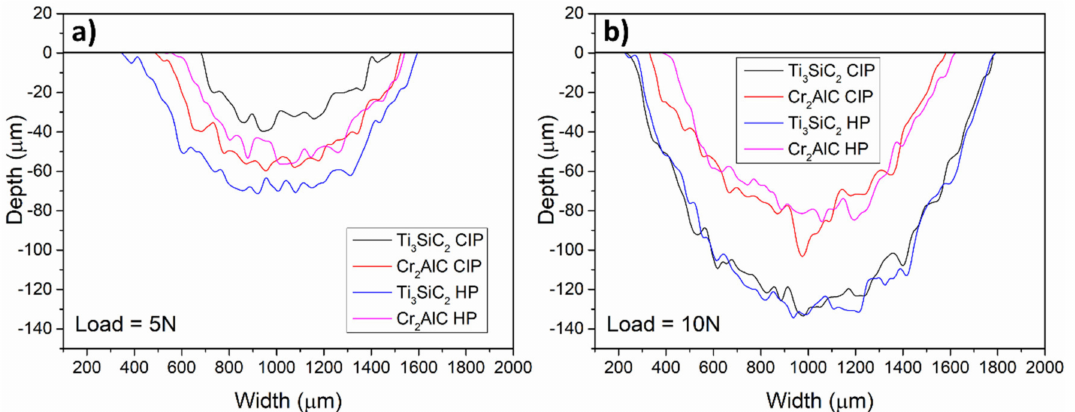
Figure 13. The 2D profiles at the center of the wear track of cold isostatic pressed and sintered (CIP) and hot-pressed (HP) Ti 3 SiC 2 and Cr 2 AlC applying ( a ) 5 N and ( b ) 10 N.